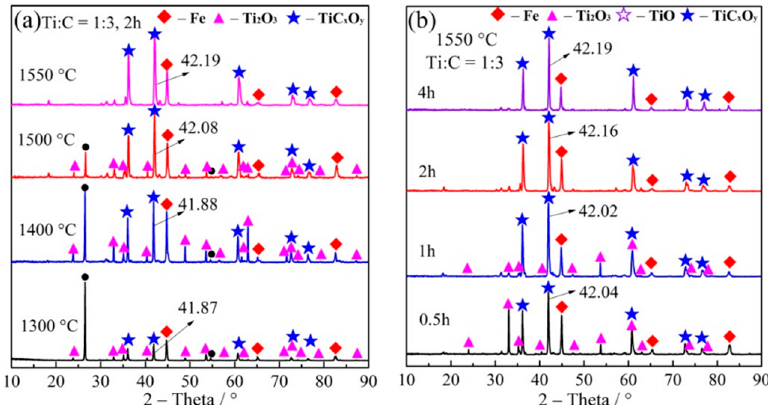
Figure 7. ( a ) XRD patterns of the reduction products of ilmenite at different temperatures; ( b ) XRD patterns of the reduction products of ilmenite at different times (1550 °C, Ti:C ratio of 1:3). The scanning electron microscopy (SEM) and energy dispersive X-ray spectrometry (EDS) of the carbon thermal reduction products (No. 10, Ti:C of 1:3, reduction time of 4 h) are shown in Figure 8a,b.